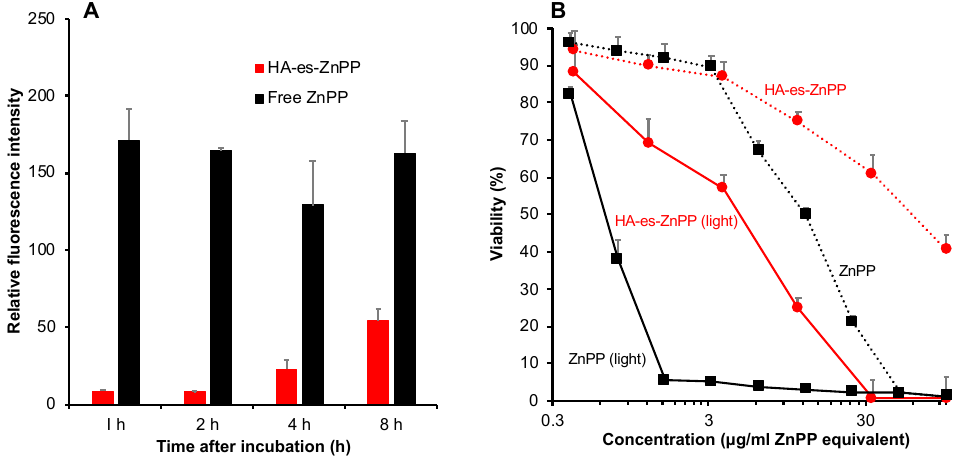
Figure 5. Intracellular uptake ( A ) and in vitro cytotoxicity ( B ) of HA-es-ZnPP in C26 colon cancer cells. ( A ), free ZnPP or HA-es-ZnPP (20 µ g/mL ZnPP equivalent) was added to C26 cells for the indicated time. The intracellular ZnPP or HA-es-ZnPP was detected and quantified by measuring fluorescence intensity. ( B ), free ZnPP or HA-es-ZnPP at different concentrations was added into the cells, and the cells were treated for 48 h. In a separate plate, cells were irradiated by using fluorescent blue light (1.0 J/cm 2 , 5 min irradiation) at 24 h after HA-es-ZnPP treatment followed by further 24 h incubation. The cell viability was then measured by MTT assay. Data are mean ± SD.